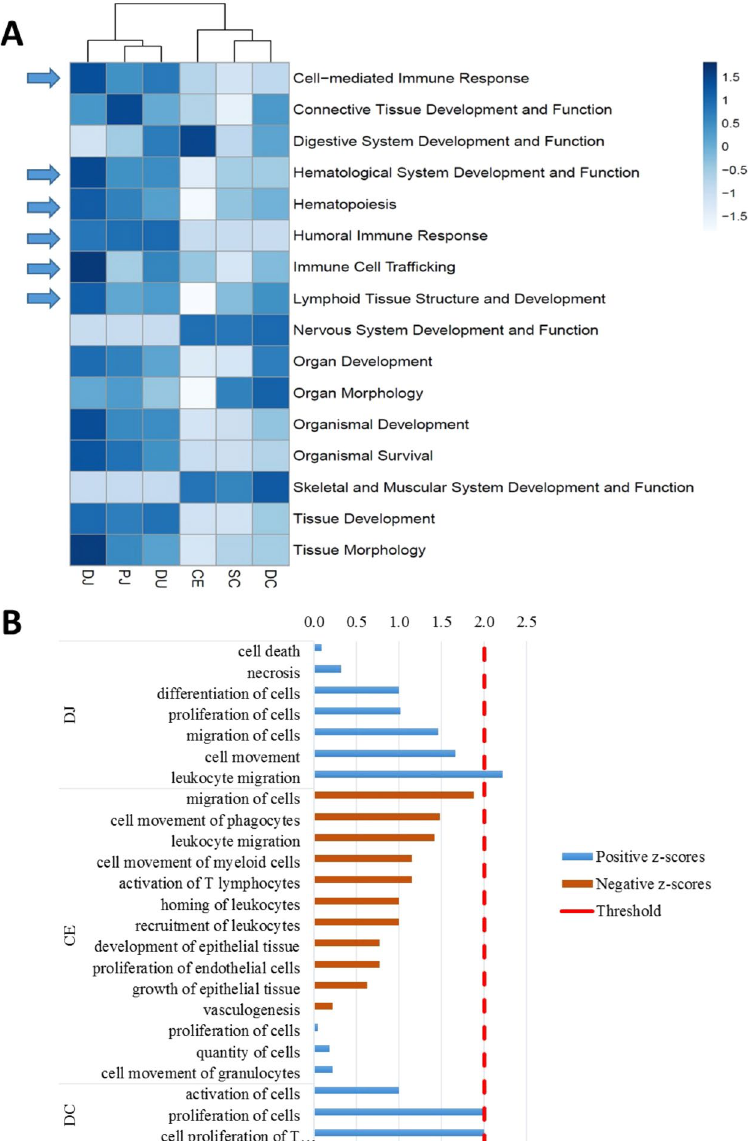
Figure 3. Function analysis for core transcriptome of cattle intestinal tissues. ( A ) IPA (Ingenuity Pathway Analysis) functional analysis of the core transcriptome of intestinal tissues. The heatmap shows scaled values of − log 10 (p-value) indicated with blue colours: the darker the blue, the more likelihood that a function is associated with the core transcriptome of a tissue. ( B ) Functional analysis for differentially expressed (DE) genes. Results obtained from IPA downstream analysis for DE genes of each tissue. Positive z-scores were indicated with blue bars and negative z-scores with brown bars. The absolute values of z-scores were plotted, and those with a threshold greater than 2 hr, considered to indicate a difference in functionality between super- shedders and non-shedders. A positive z-score indicates enhancement, while a negative z-score indicates a reduction in function. DJ, distal jejunum; CE, cecum; SC, spiral colon; DC, descending colon; for differentially expressed genes identified in the other tissues, no IPA functional terms were